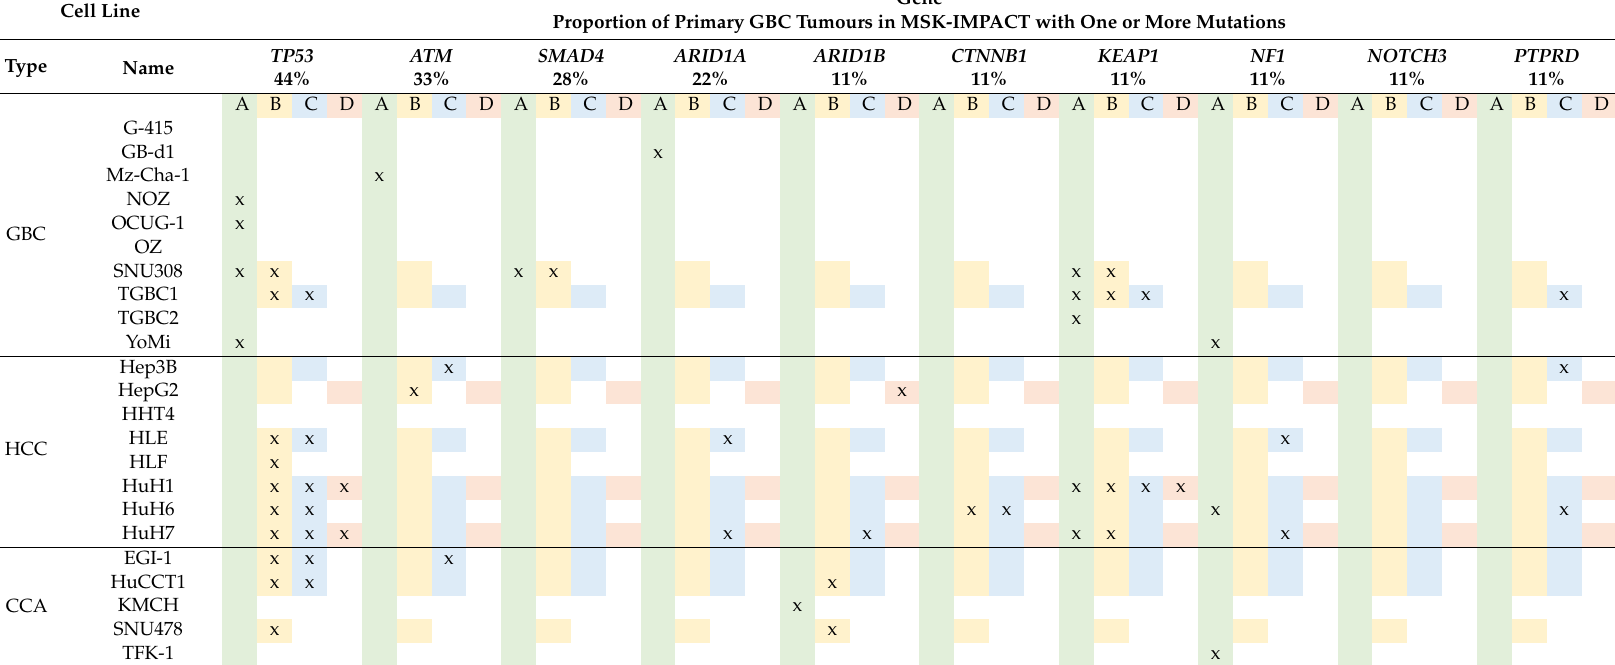
Cells with colored background indicate data availability for the respective cell line in the specific database / project. Columns A: data from the present study (green); B: data from the Cancer Cell Line Encyclopedia (CCLE) (yellow); C: data from the Catalog of Somatic Mutations in Cancer (COSMIC) Cell Lines Project (blue); D: data provided by Klijn et al., 2014 (red)